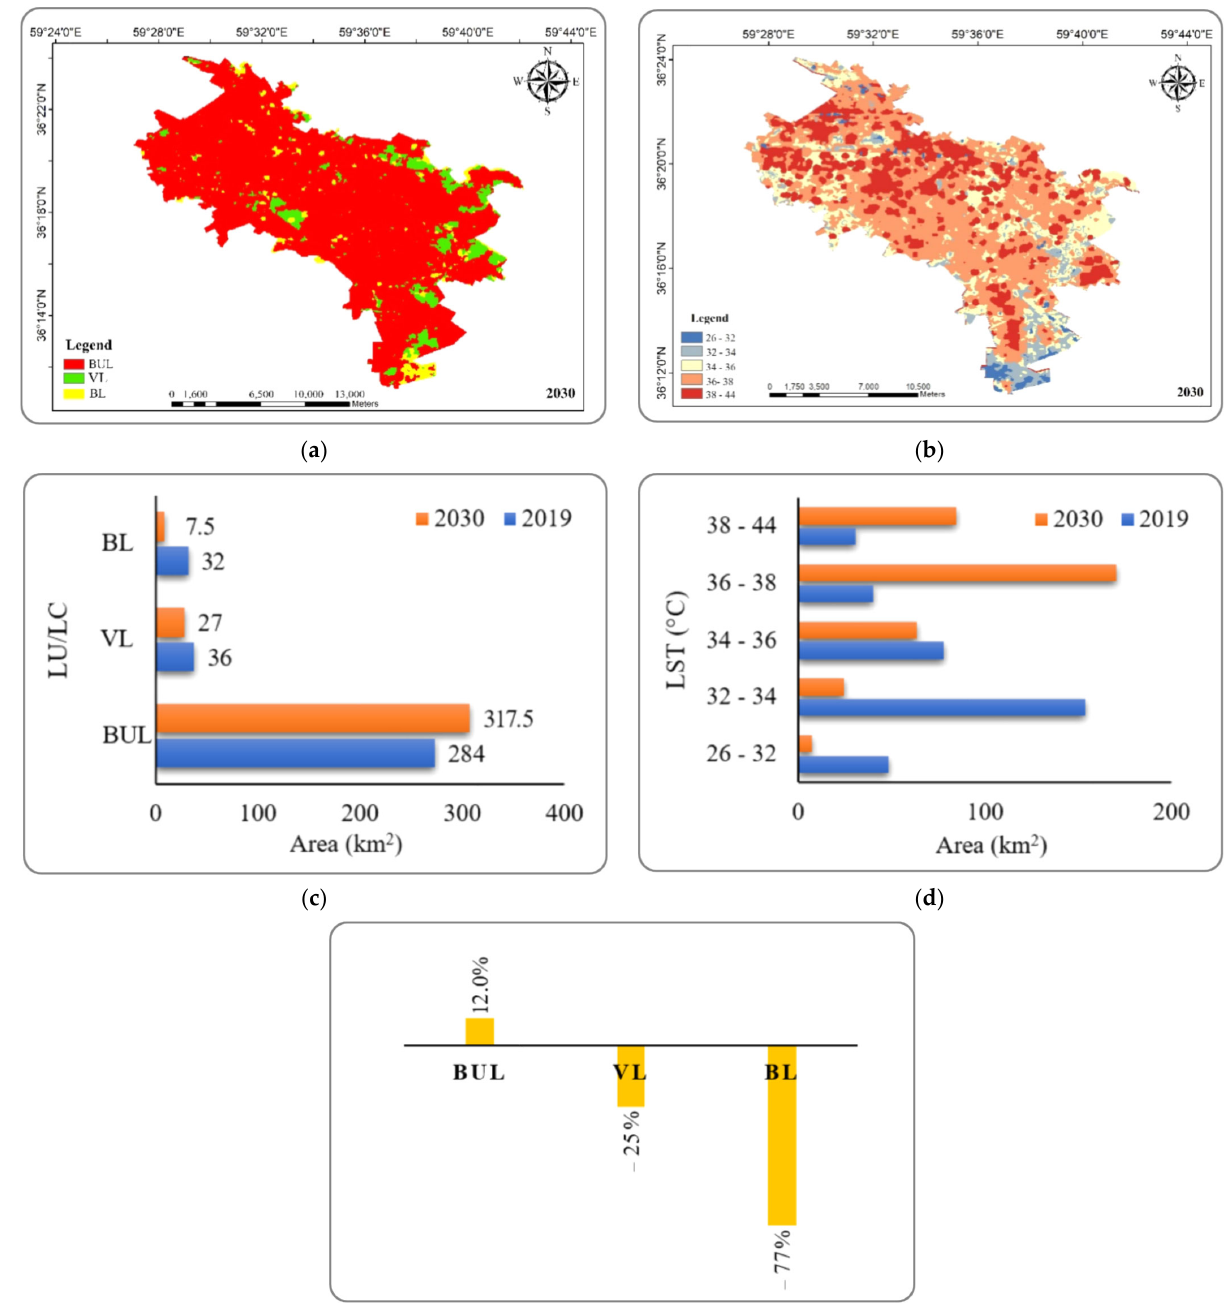
Figure 10. Forecast of LU/LC and LST maps of Mashhad city for 2030 (panels ( a , b ), respectively) and the comparison of changes in LU/LC and LST that occurred between 2019 and 2030 (panels ( c – e ), respectively). In ( c ), a comparison of the area of analyzed LU/LC is presented, whereas ( d ) shows the changes in LST ranges. In ( e ), the percentage change in relation to the area occupied by specific LU/LC classes in 2019 is presented.